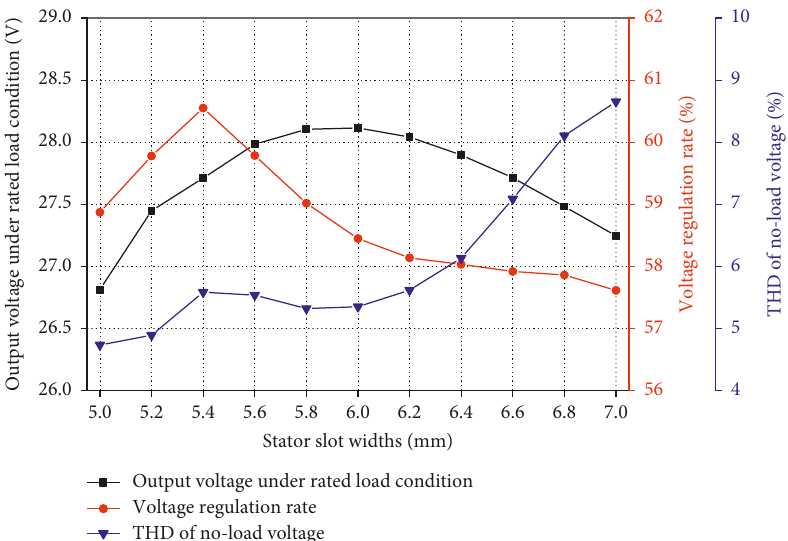
Figure 9: Variation curves of generator output performance with different stator slot widths.